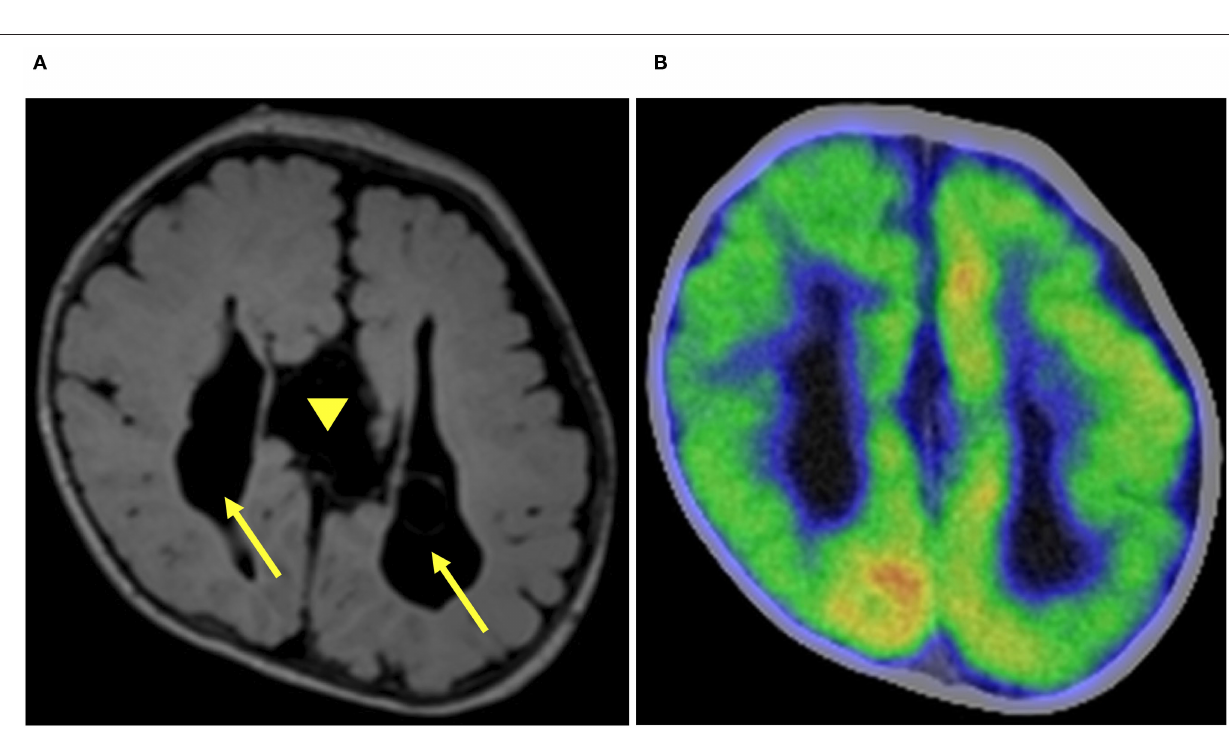
FIGURE 2 | Preoperative imaging. Preoperative axial fluid-attenuated inversion recovery magnetic resonance imaging (FLAIR MRI) demonstrated corpus callosum agenesis (arrow head) and bilateral (right dominant) ventricular dilatation (arrow) (A) . Fluorodeoxyglucose-positron emission tomography-computed tomography showed hypometabolism in the right hemisphere (B)